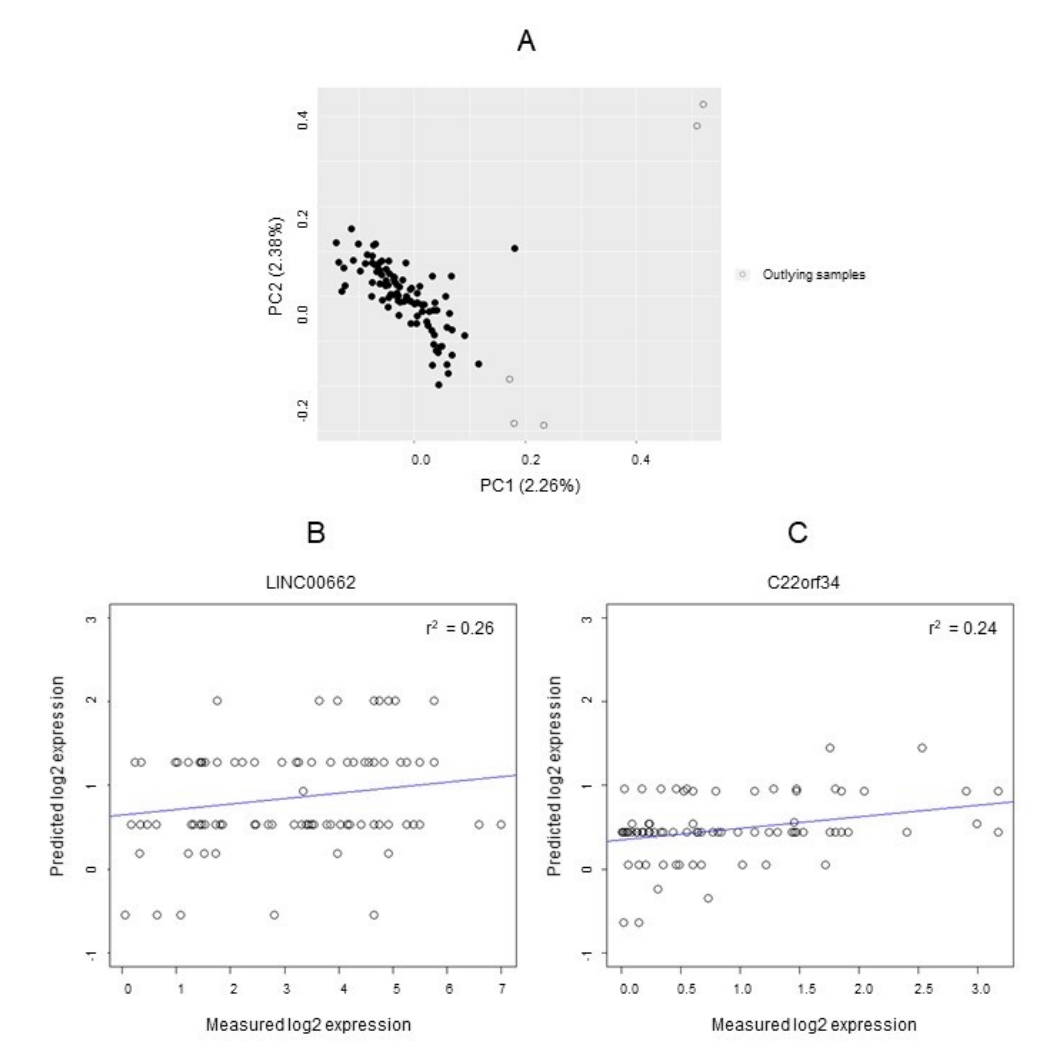
Figure 3. LncRNA-eQTL validation. ( A ) Genetic PCA based on LD-pruned genotypes from the lncRNA-eQTL validation dataset. ( B , C ) Measured vs. predicted log2 expression for LINC00662 and C22orf34,